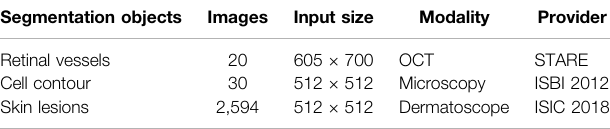
TABLE 3 | The results of ablation study for LR-ASPP.